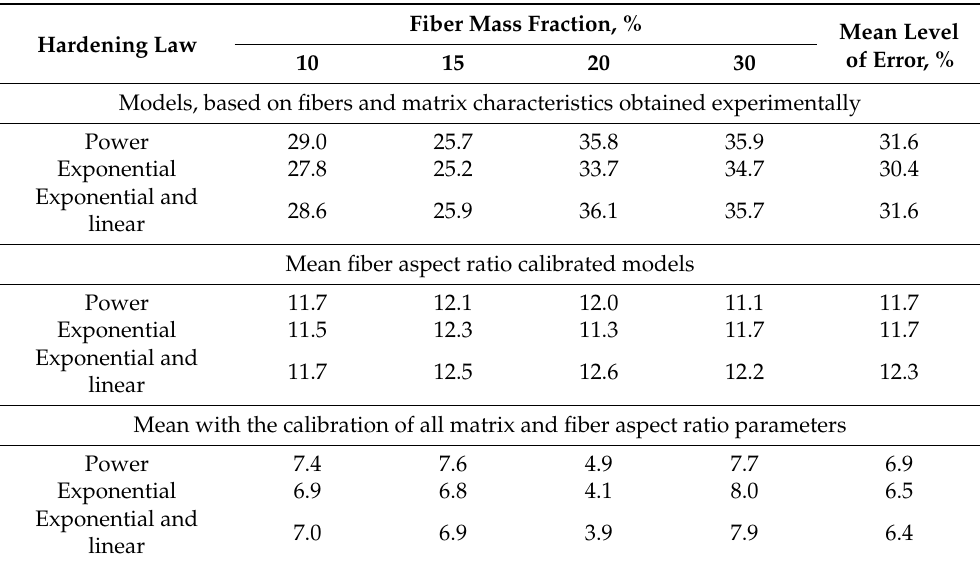
Table 5. Mean relative error of stress–strain curve prediction of different fiber mass fraction com- posites with models based on fibers and matrix characteristics obtained experimentally, mean fiber aspect ratio calibrated models, and the mean parameter